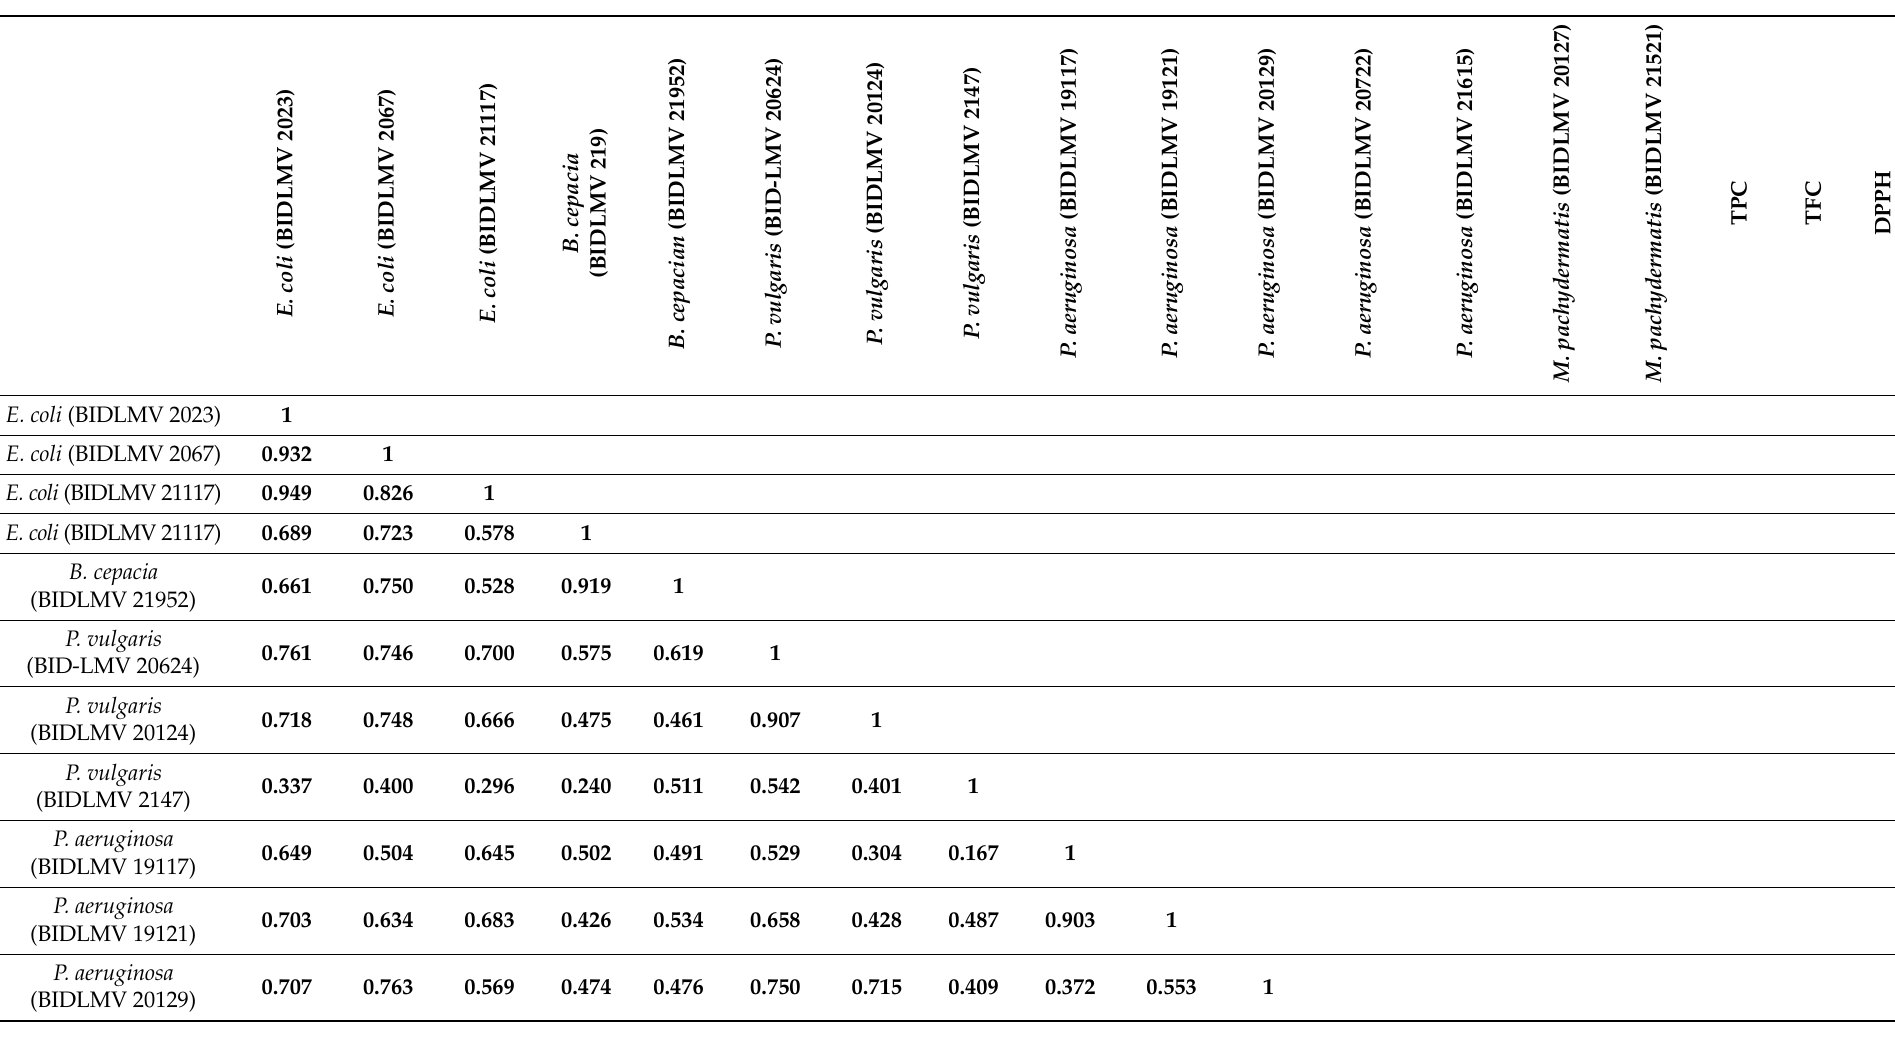
Table 4. Pearson correlation coefficient matrix for antimicrobial activity on the clinical isolates and antioxidant activity of honey